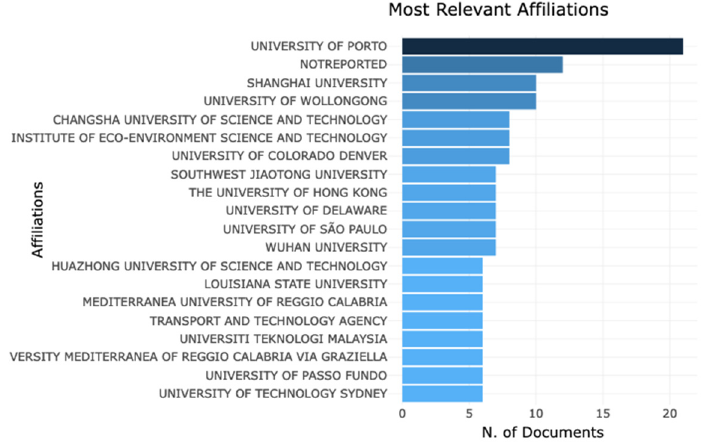
Table 6. Distribution of authors’ production. Figure 6. Most relevant affiliations. Figure 6. Most relevant affiliations.